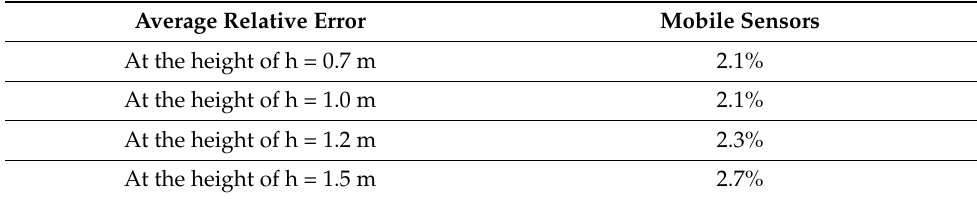
Table 3. Prediction of different heights using mobile sensors.